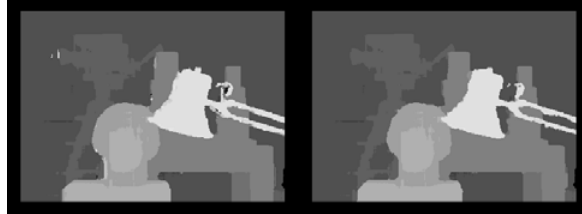
Figure 5. Disparity map of the left Tsukuba image before (left) and after (right) occlusions and mismatches have been handled.